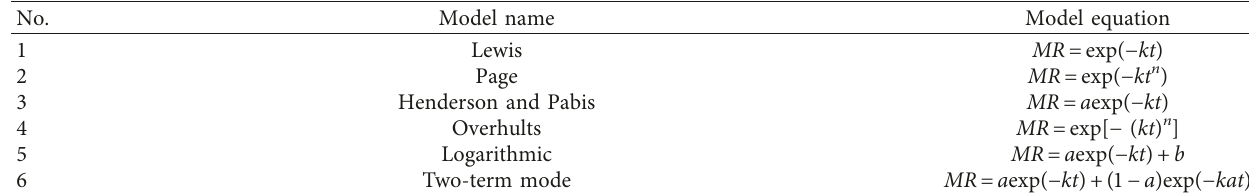
Table 4: Mathematical thin-layer drying models.